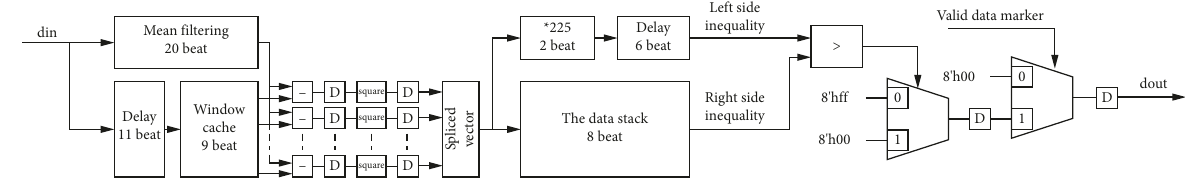
Figure 2: Overall design.